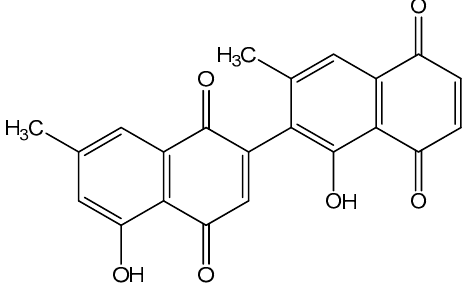
Figure 1. Chemical structure of diospyrin.